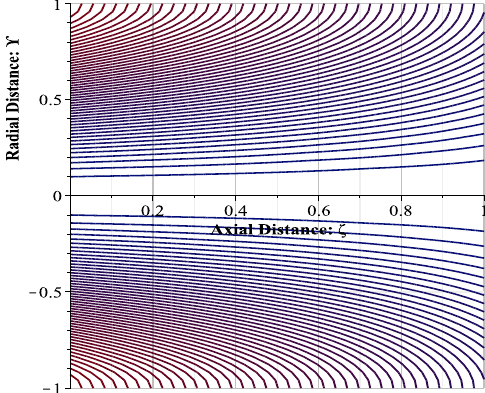
Figure 8. Stream lines for W RE = 0.5 × 10 − 5 .